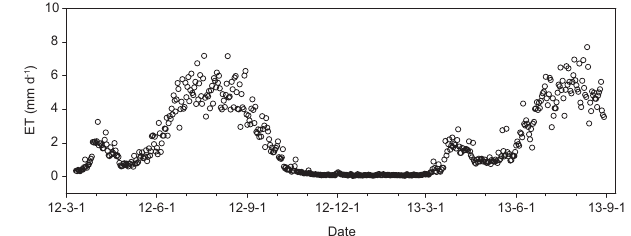
Figure 6. Seasonal evapotranspiration variation during